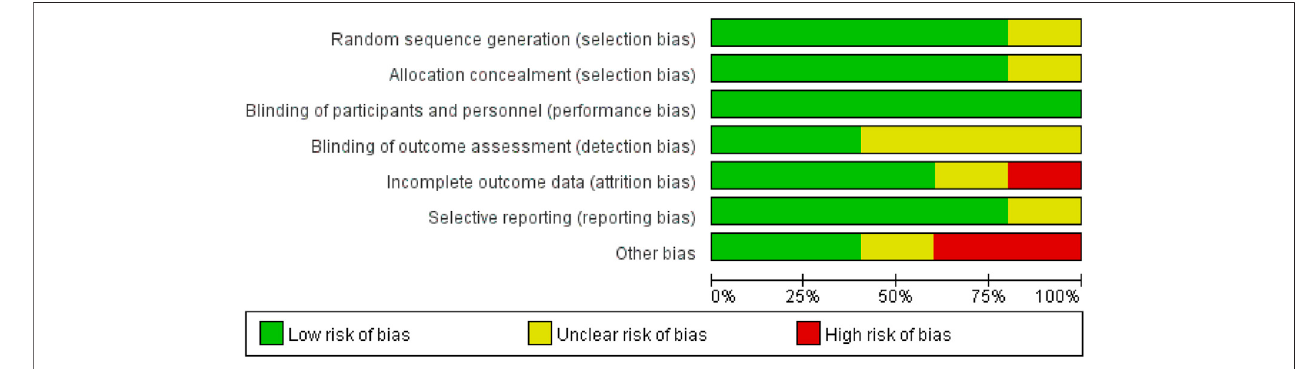
FIGURE 1 | Risk of bias graph.